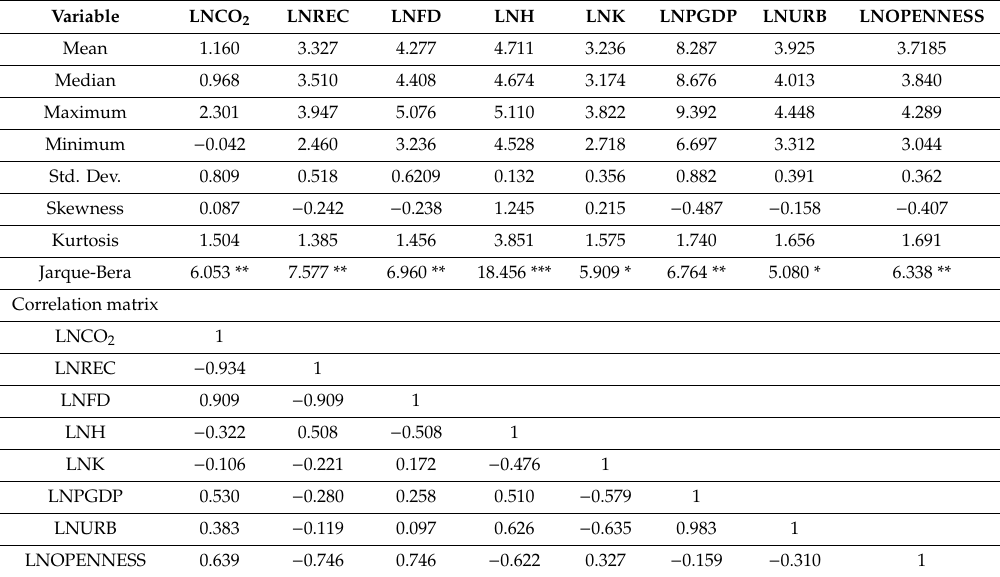
Table 4. Results of descriptive statistics and correlation